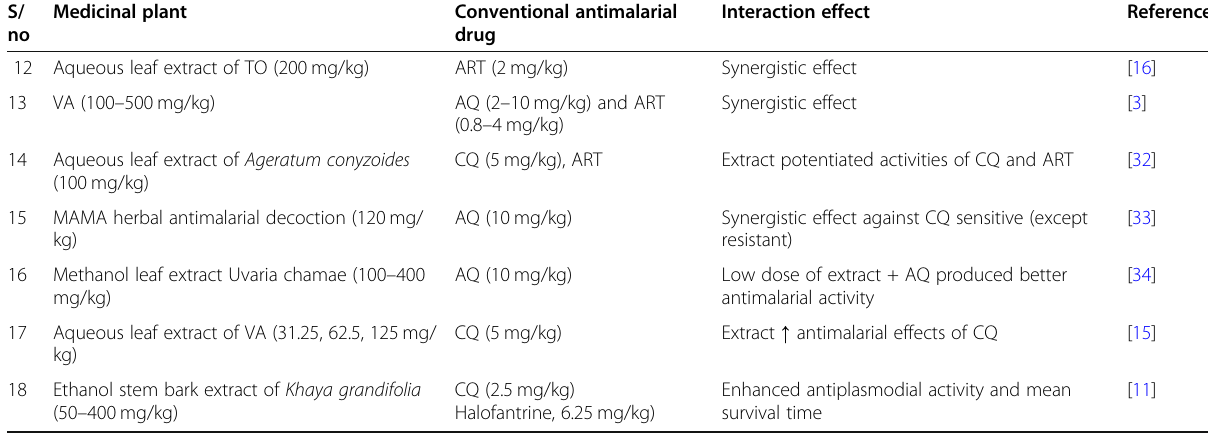
Table 2 Summary of studies on herbal-antimalarial drugs interactions using P. berghei and P. yoelii nigerense model S/ Medicinal plant Conventional antimalarial no